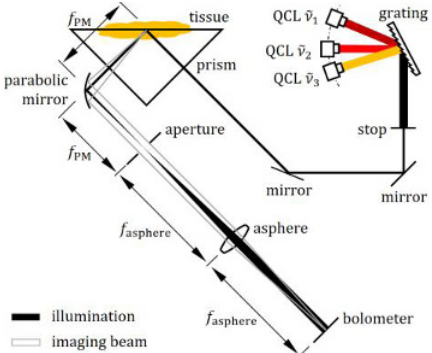
Fig. 3. Possible setup for a multi-spectral ATR spectrometer. The tissue is illuminated by multiple DFB-QCLs and the attenuated reflections are imaged using a